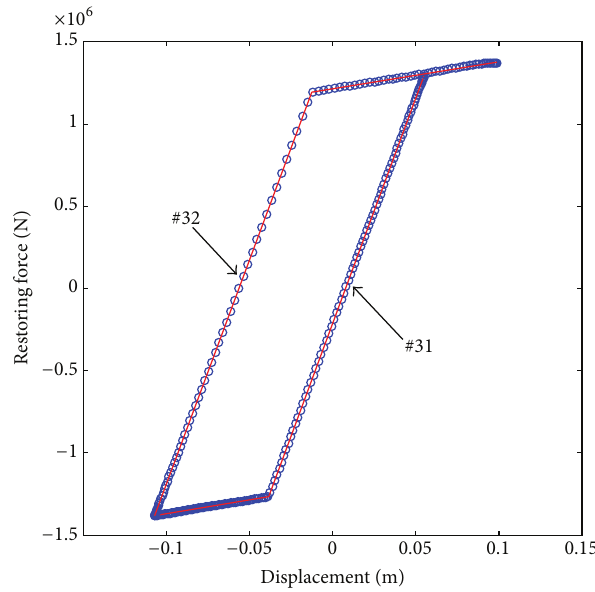
Figure 5: Identified nonlinear half cycles and multiphase linear regression results for 2 half cycles. The line is the identified model and the circles are the simulated